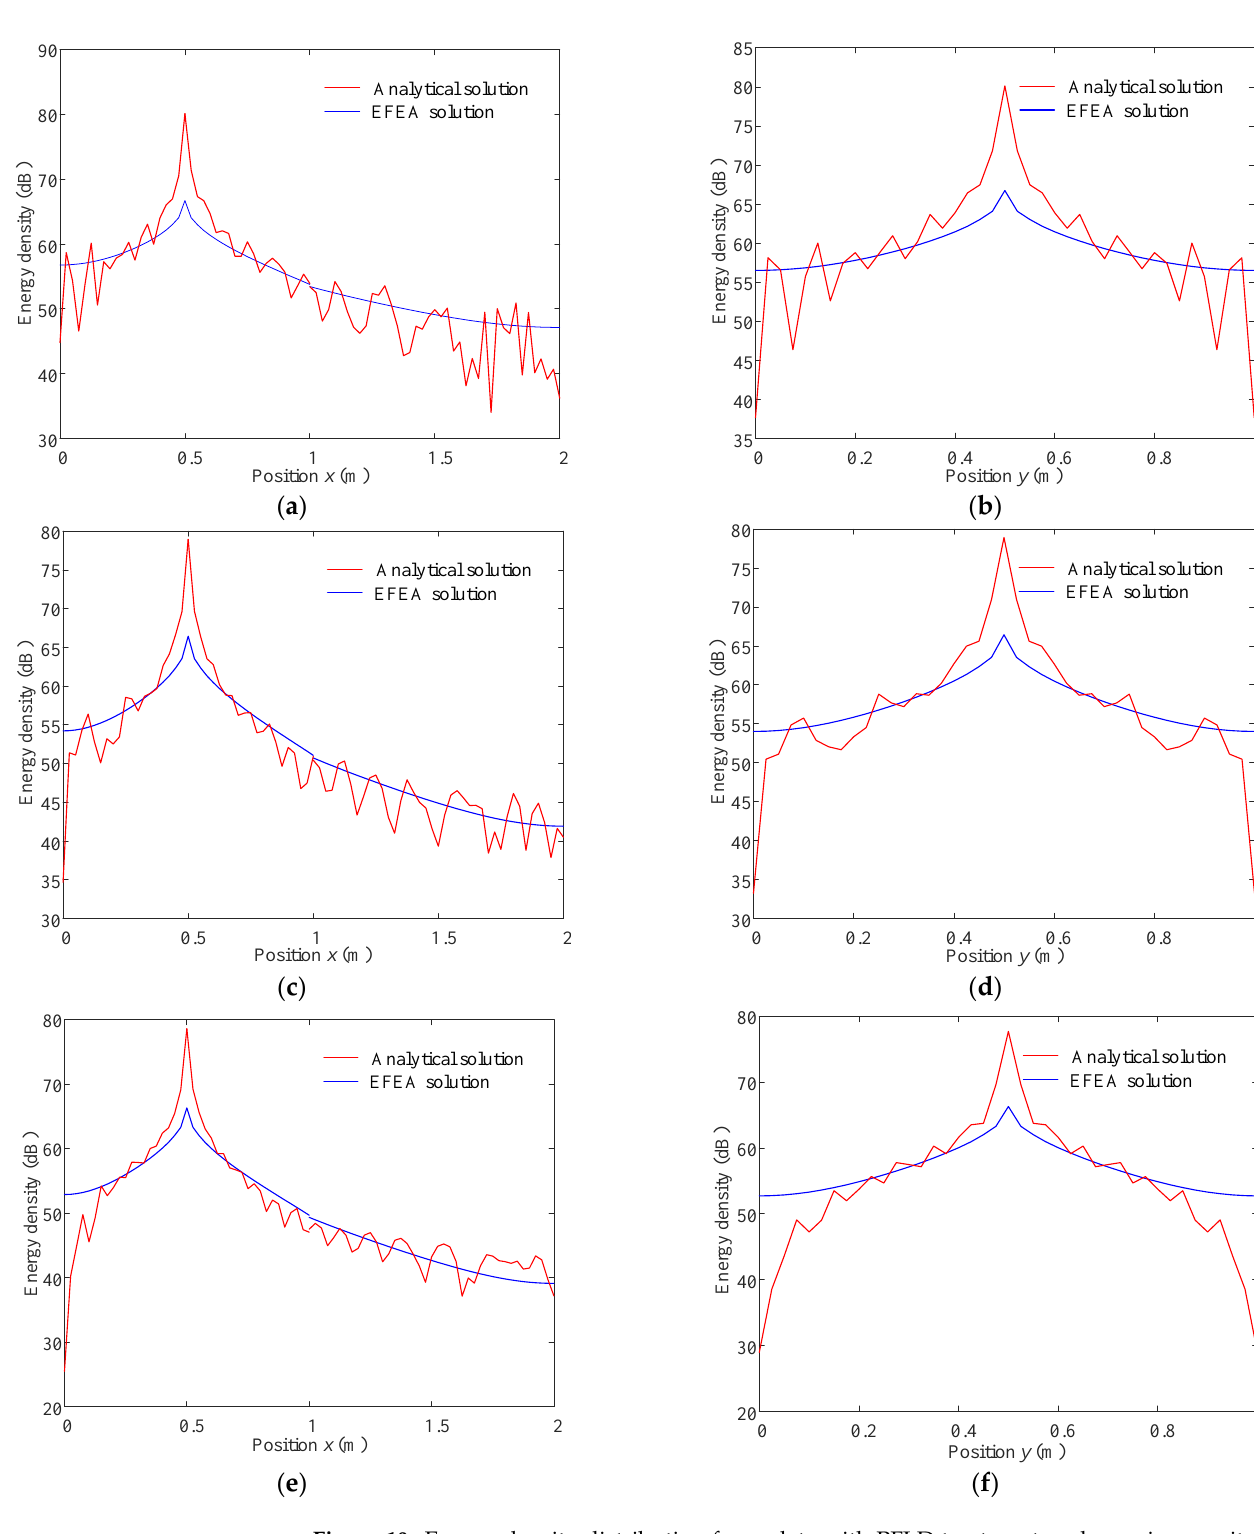
Figure 10. Energy density distribution for a plate with PFLD treatment under various excitation frequency ( η 2 = 0.8, h 2 = 0.002 m). ( a ) Energy density distribution at y 0 = 0.5 m ( f = 5 kHz). ( b ) Energy density distribution at x 0 = 0.5 m ( f = 5 kHz). ( c ) Energy density distribution at y 0 = 0.5 m ( f = 8 kHz). ( d ) Energy density distribution at x 0 = 0.5 m ( f = 8 kHz). ( e ) Energy density distribution at y 0 = 0.5 m ( f = 10 kHz). ( f ) Energy density distribution at x 0 = 0.5 m ( f = 10 kHz).